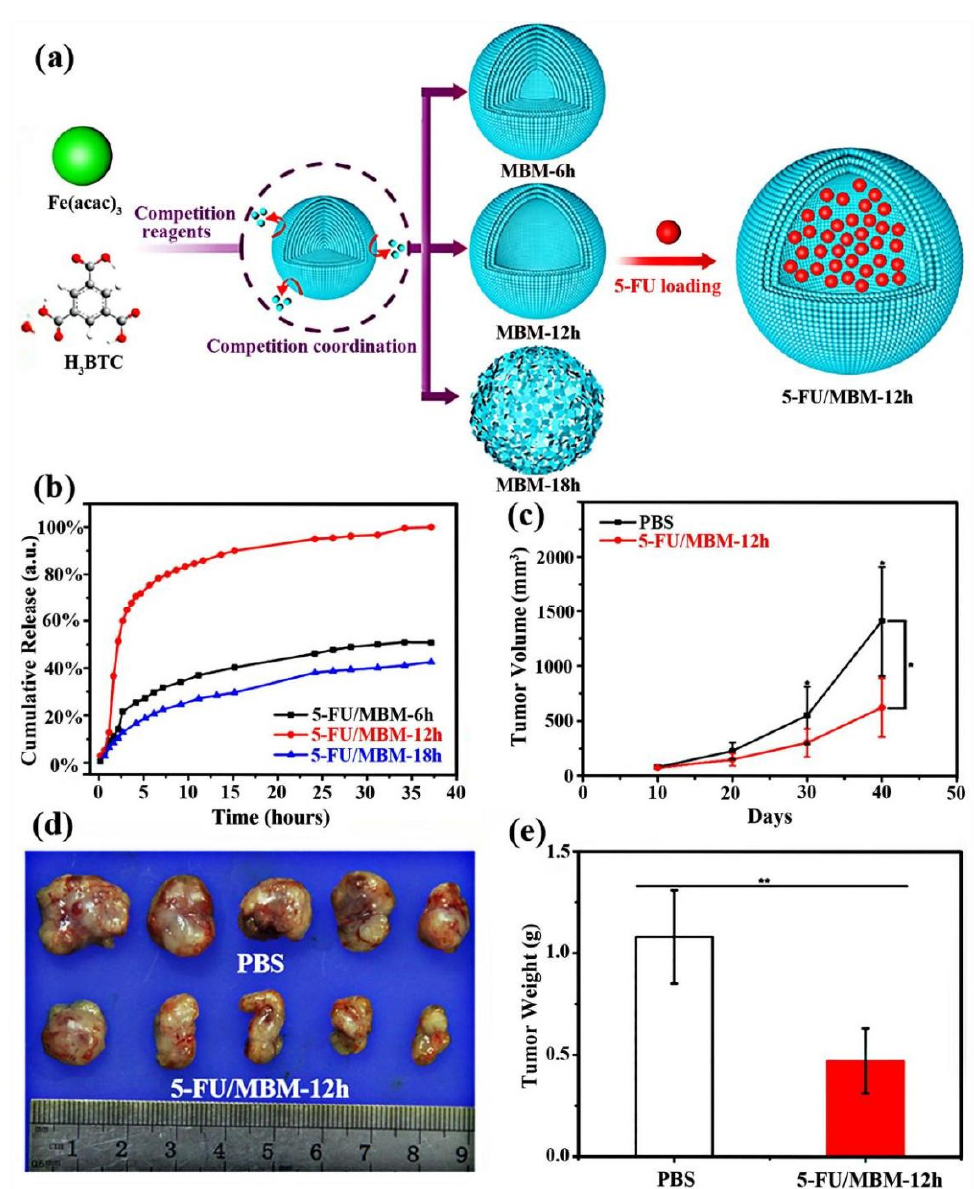
Figure 5. ( a ) The synthetic process of 5-FU/MBM-12 h. ( b – e ) Drug release and tumor treatment. Reproduced with permission from Ref. [75], copyright (2021) the American Chemical Society. (* p < 0.05; ** p < 0.01).